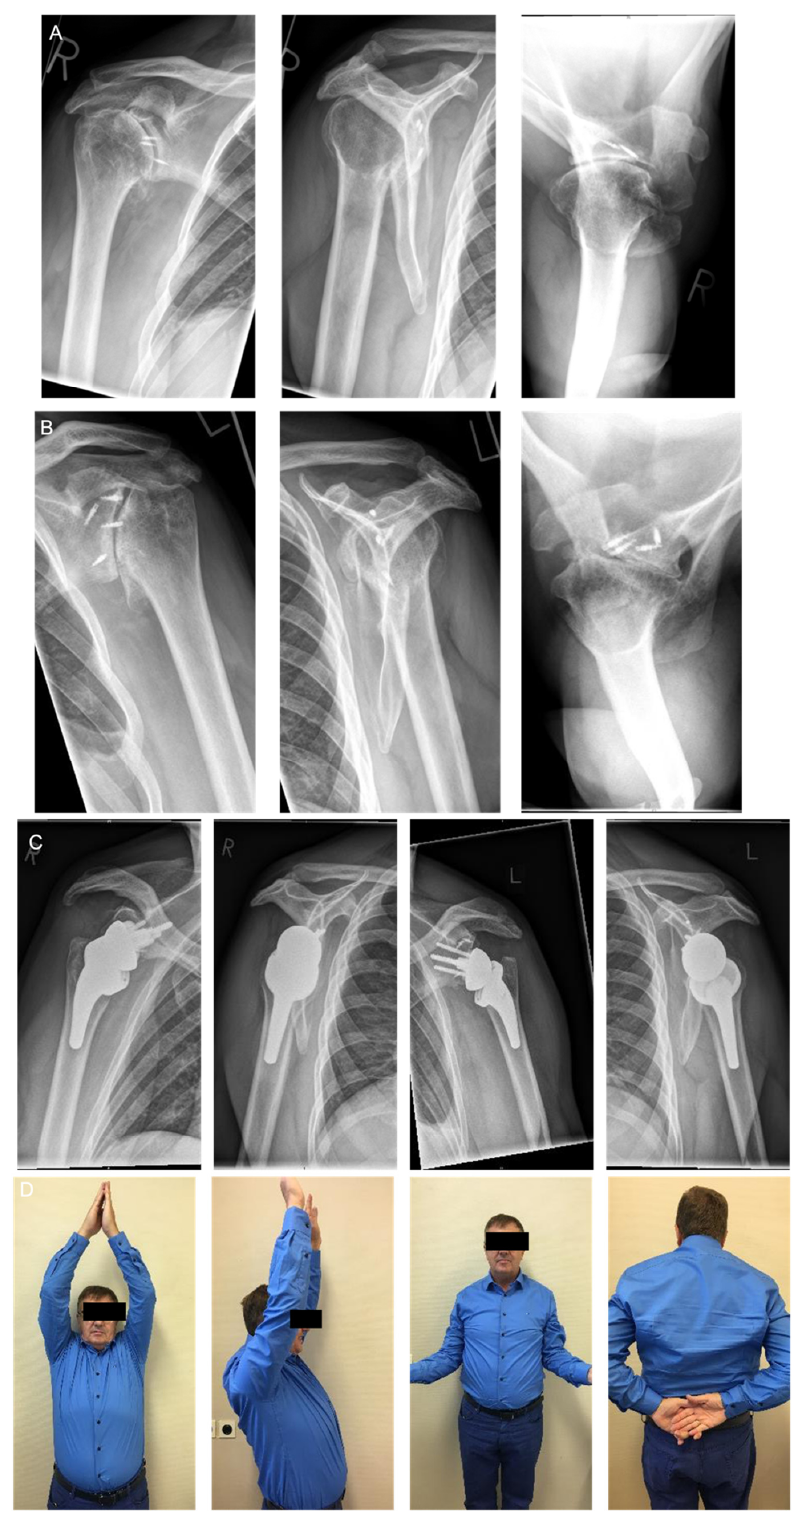
Figure 6. 61-year-old male with bilateral dislocation arthropathy. ( A ): right shoulder dislocation arthropathy after instability surgery. ( B ): left shoulder dislocation arthropathy after instability surgery. ( C ): treatment with bilateral two surgeries Reverse Shoulder Arthroplasty using full wedge. ( D ): right side 12 months follow up and left side 6 months follow up clinical results.